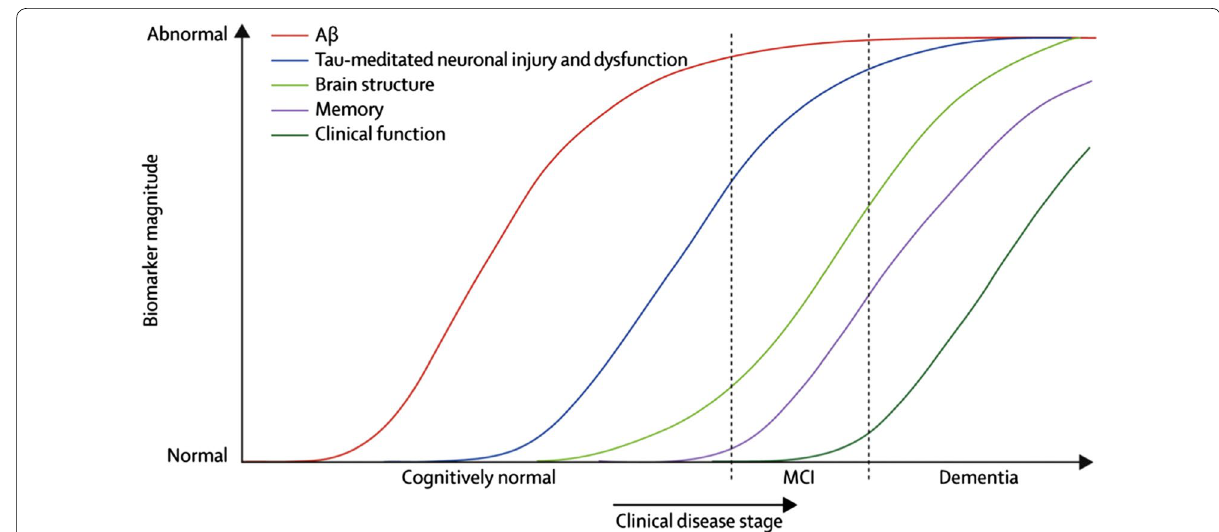
Fig. 3 Hypothetical model for biomarker dynamics in the progression of Alzheimer’s disease